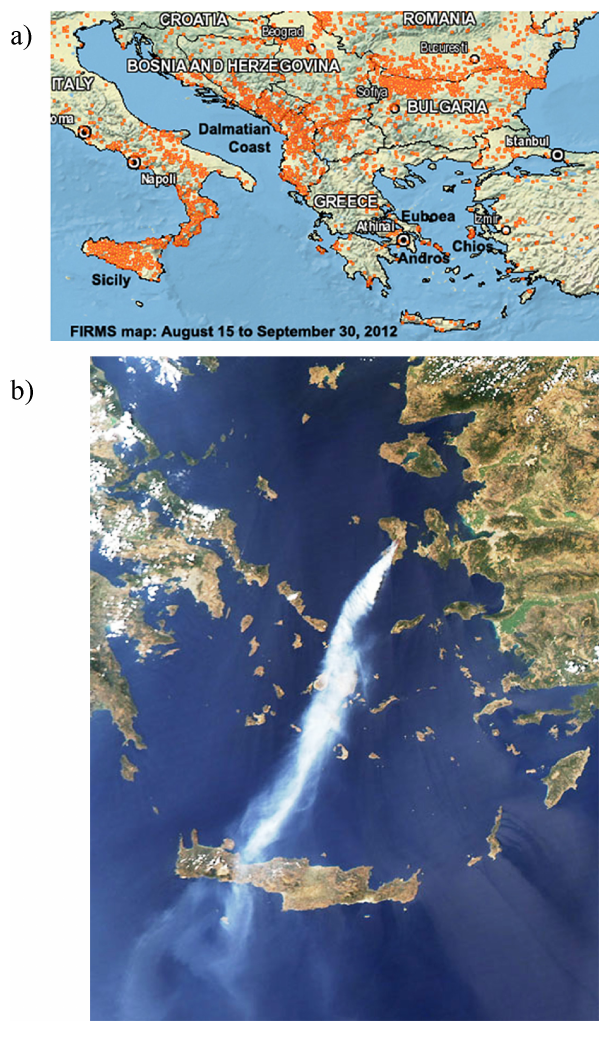
Fig. 1. (a) Occurrence of wildfires as spotted by the Fire Infor- mation for Resource Management System (FIRMS) (http://firms. modaps.eosdis.nasa.gov/firemap/) during the whole measurement period (1 August–30 September) with specific locations high- lighted in red and (b) MODIS image of the Chios fire (18 August 2012, http://earthobservatory.nasa.gov/IOTD/view.php?id=